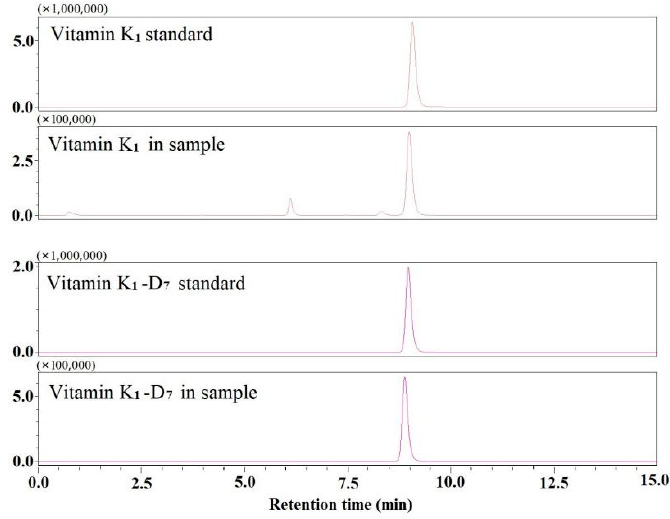
Figure 4. Representative multiple reaction monitoring (MRM) ion chromatograms of vitamin K 1 and vitamin K 1 -D 7 in reference standards and samples.